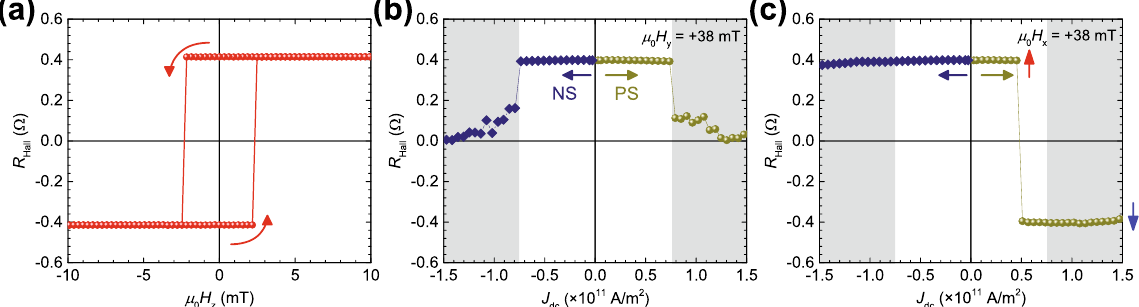
Figure 2. Anomalous Hall measurement under various dc currents. ( a ) Results of anomalous Hall resistance R Hall measurement by sweeping perpendicular field μ 0 H z . Densities of dc current J dc used here are + 2.8 × 10 9 A/ m 2 . Sweep rate of μ 0 H z was ~0.04 mT/s. Measurements were performed at stage temperature of 304 K. Red arrows indicate the sweep direction. ( b , c ) R Hall as a function of J dc obtained under μ 0 H y ( b ) and μ 0 H x ( c ) of + 38 mT. Shaded area indicates the J dc region where multiple domain state appears under y -field. The error bar, which is the standard deviation of two data points, is smaller than the symbols.